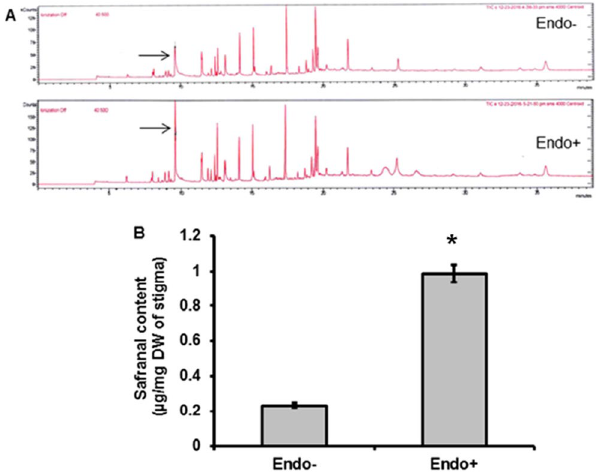
Figure 3. Effect of the CS10E4 on safranal content of saffron. ( A ) GC-MS chromatograms showing safranal peaks in endophyte treated (Endo + ) and control (Endo − ) plants ( B ) Bar diagram showing safranal content ( µ g/mg dry weight of stigma). Values are the means ± S.D. Comparisons among means were carried out using